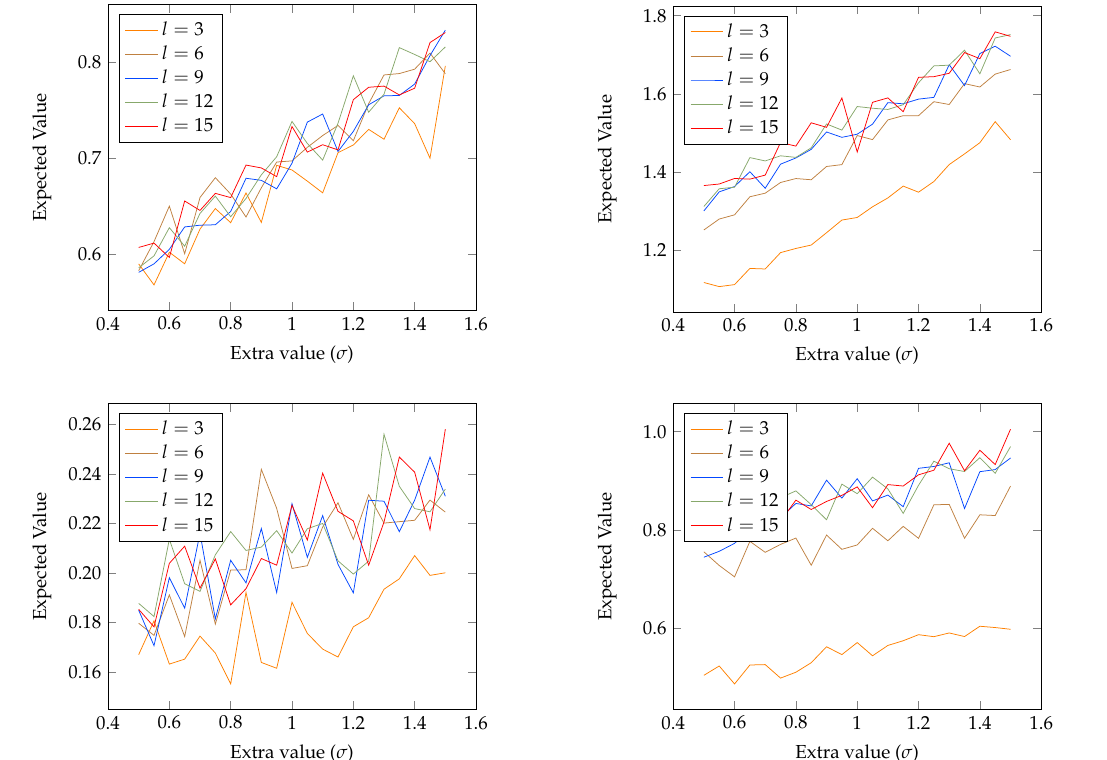
Figure 5. Results for value test. Values on the left are computed with β = 0.15 while graphs on the right have β = 0.25. As before, graphs at the top contain values computed considering a successful attack, the creation of a private chain with length equal to the main chain. At the bottom, the attacker succeeds only if its private chain is one block longer than the honest